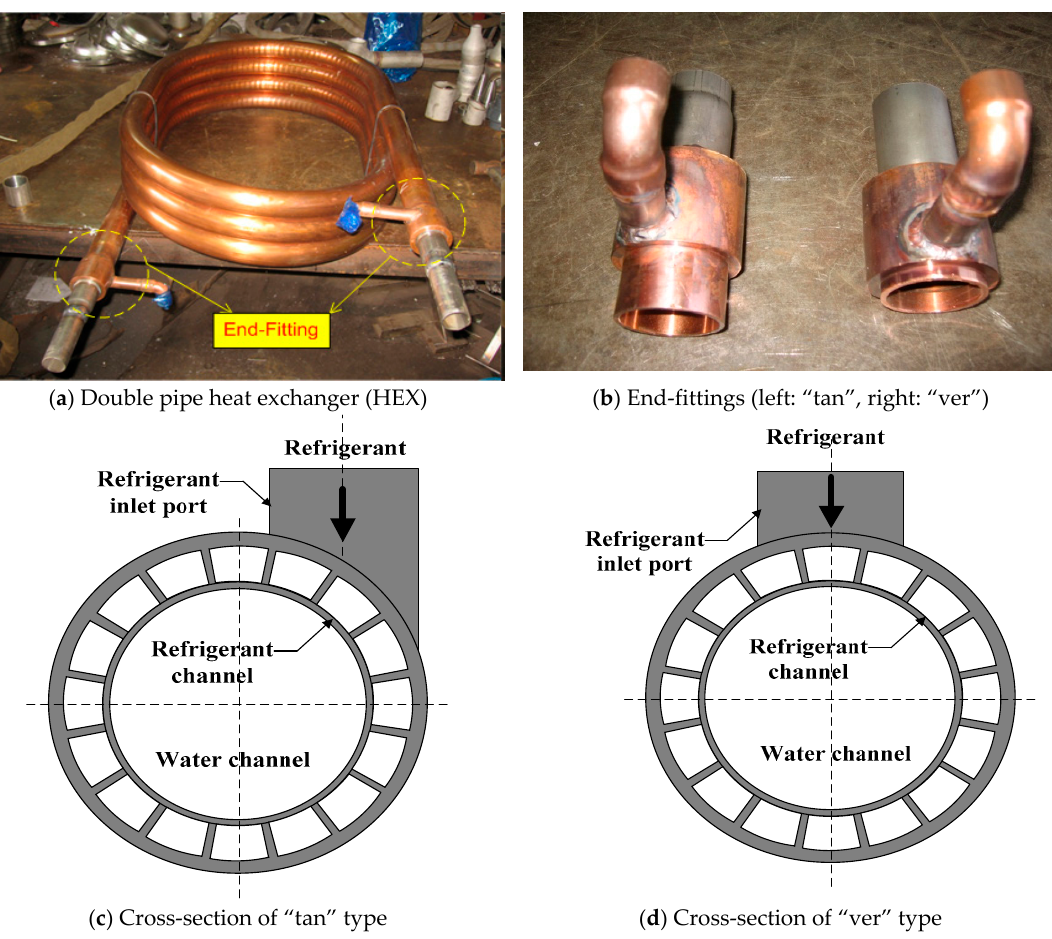
Figure 6. Two types of end-fittings of the double pipe heat exchanger. Table 2. List of measuring devices, specifications, and uncertainty.